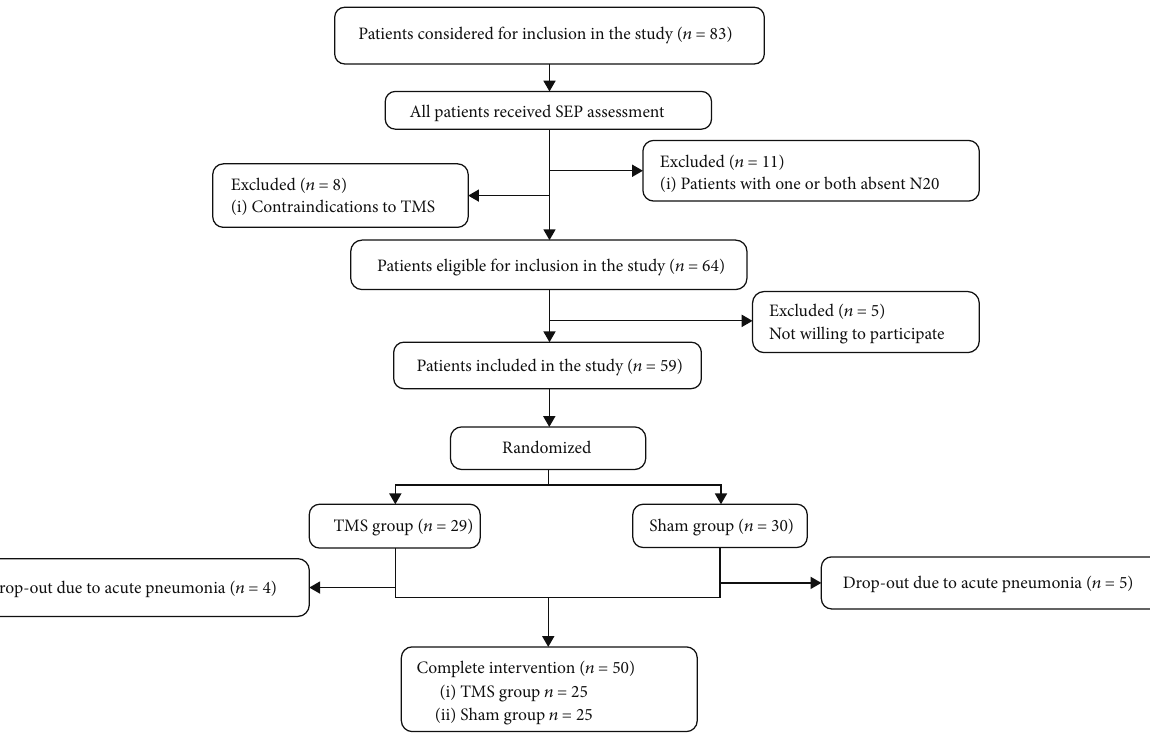
Figure 1: Flow chart of the study.